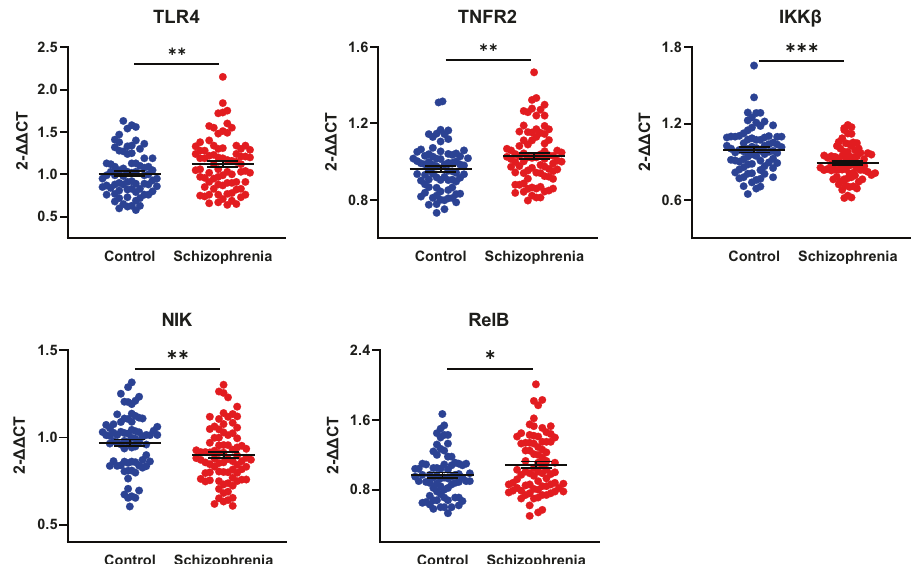
Fig. 2 Peripheral blood leukocyte gene expression of NF- κ B pathway transcripts in healthy controls and people with schizophrenia. Lines and whiskers in graphs represent mean + standard error. ***unadjusted p < 0.001, **unadjusted p < 0.01, *unadjusted p < 0.05. The diagnostic difference in IKK β mRNA remained signi fi cant after multiple comparisons correction (adjusted p < 0.02).